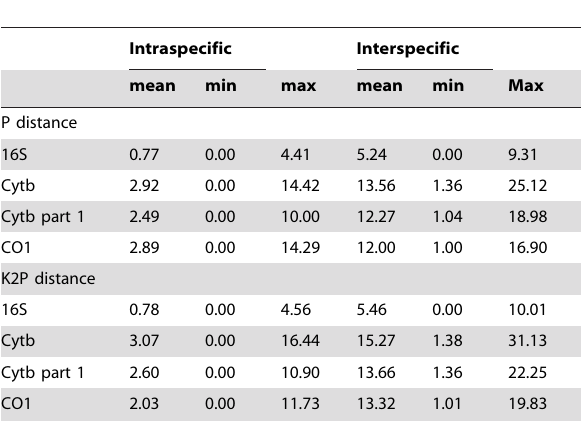
Table 1. Mean, minimum and maximum distances observed between individuals of the same (intraspecific) or distinct species (interspecific) for each gene.